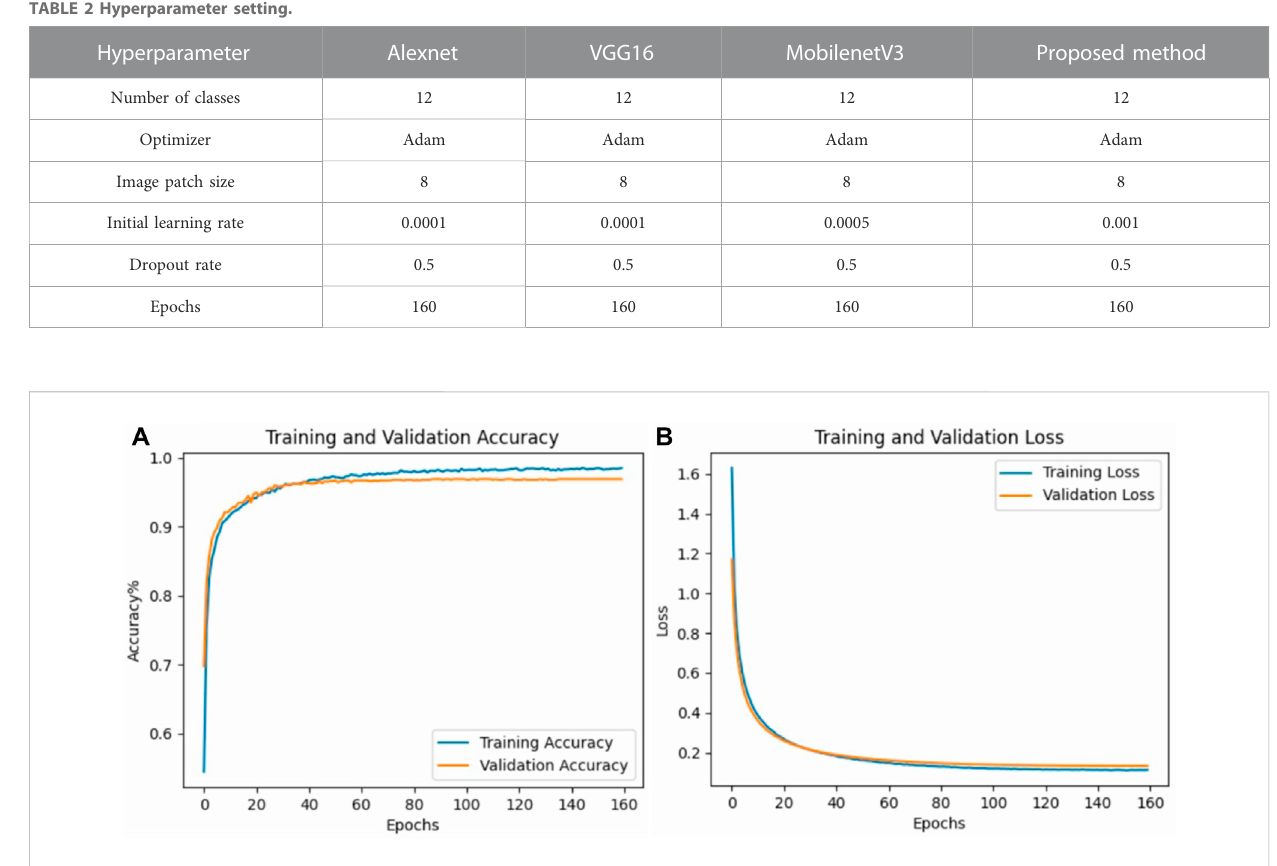
FIGURE 7 (A) Accuracy curve of the proposed method. (B) Loss curve of the proposed